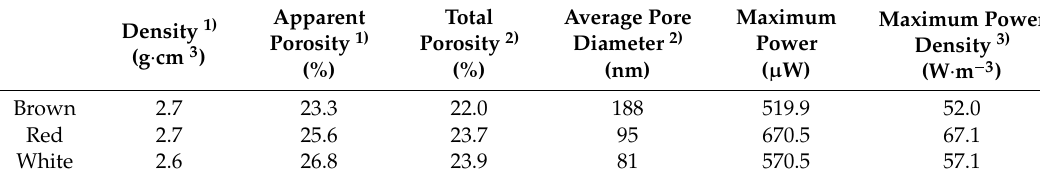
Table 1. Results of porosity and pore size